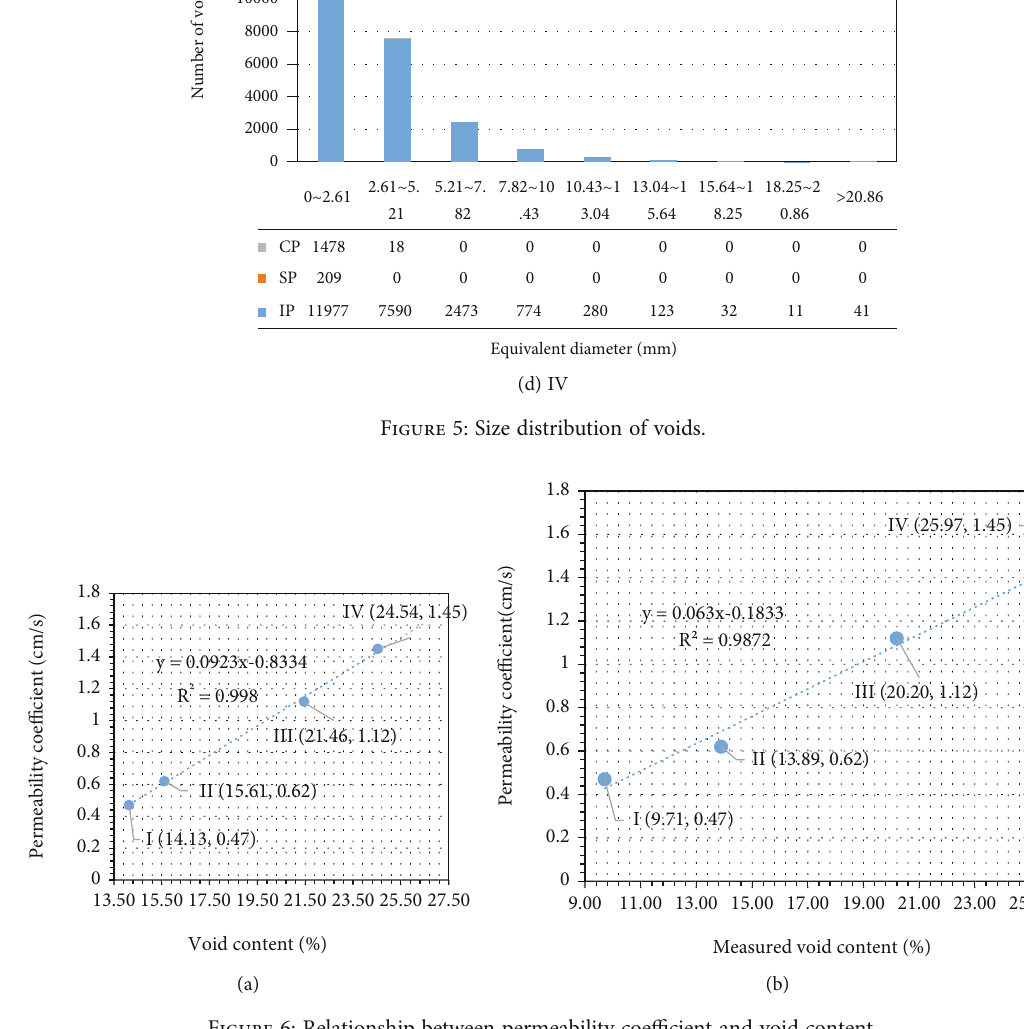
Figure 6: Relationship between permeability coe ffi cient and void